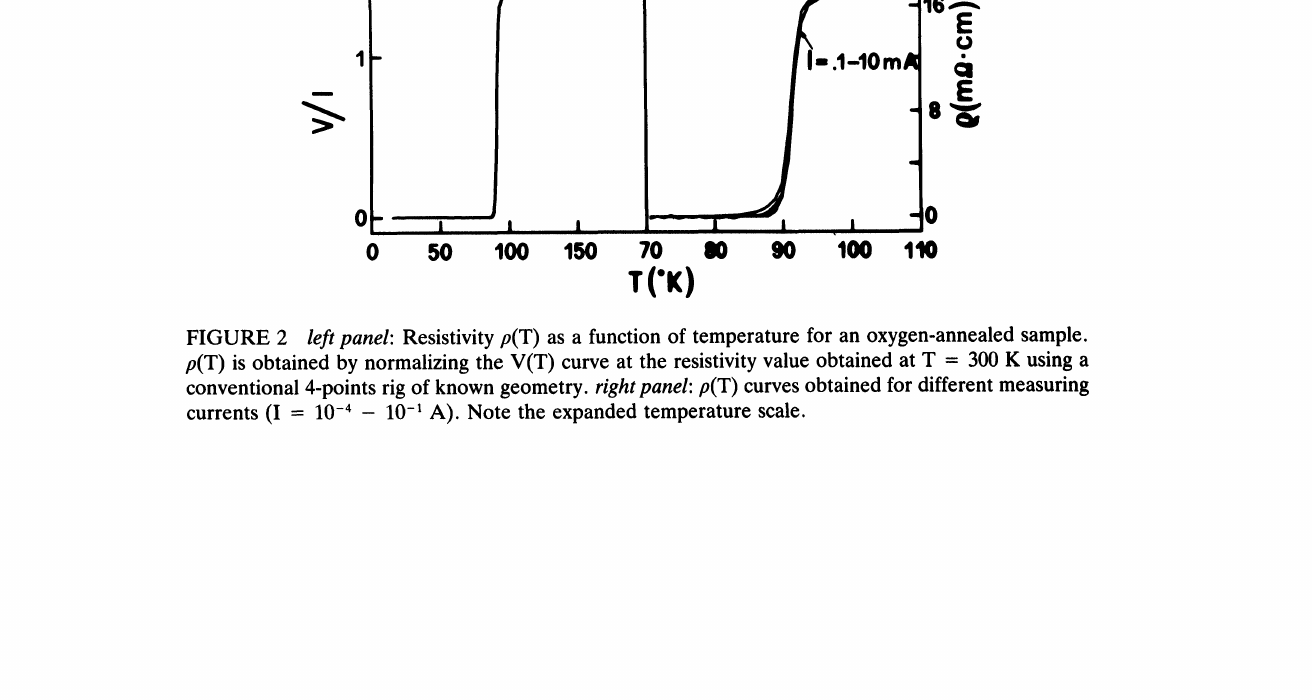
FIGURE 2 left panel: Resistivity p(T) as a function of temperature for an oxygen-annealed sample. p(T) is obtained by normalizing the V(T) curve at the resistivity value obtained at T 300 K using a conventional 4-points rig of known geometry, right panel: p(T) curves obtained for different measuring currents (I 10 -4 10 -1 A). Note the expanded temperature